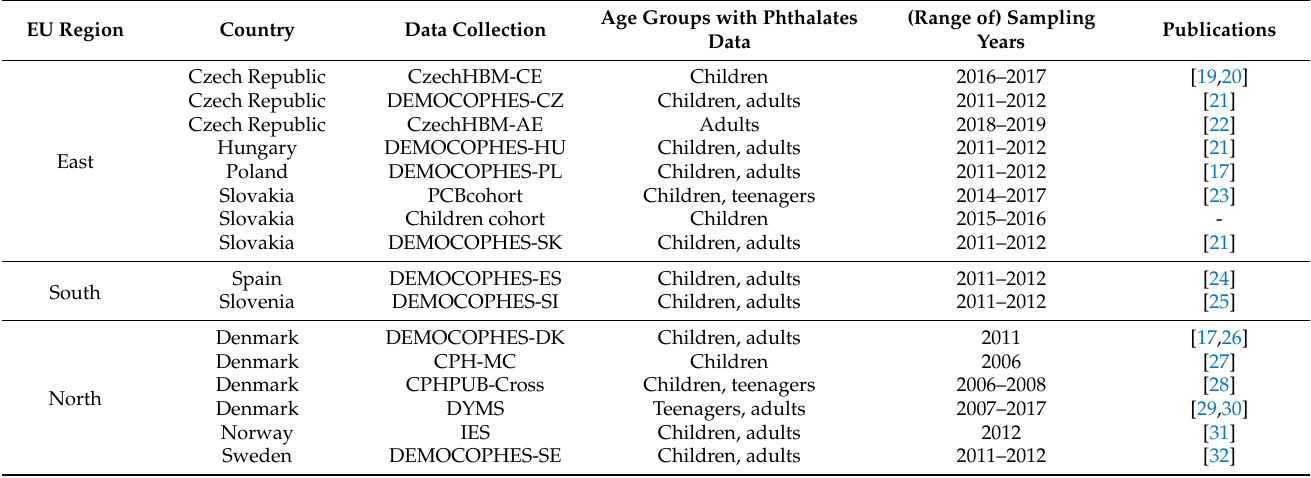
Table 1. Harmonized, aggregated existing HBM studies collected within HBM4EU with phthalate and or DINCH measured in